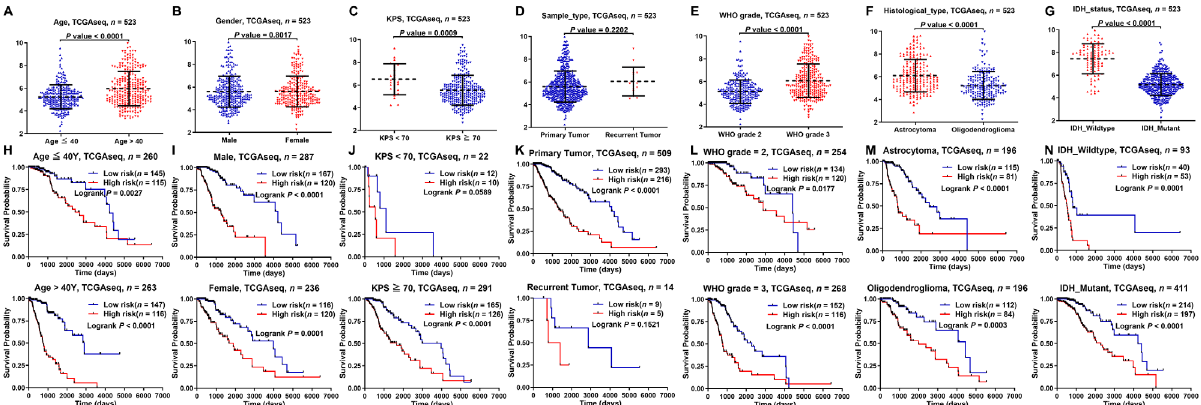
Figure 4. Kaplan-Meier analysis of survival differences stratified by clinicopathological variables between the low- and high-risk groups in the TCGA database. (A–G) Risk score differences stratified by clinicopathological variables between the low- and high-risk groups; (H–N) Kaplan-Meier analysis of survival differences stratified by clinicopathological variables between the low- and high-risk groups